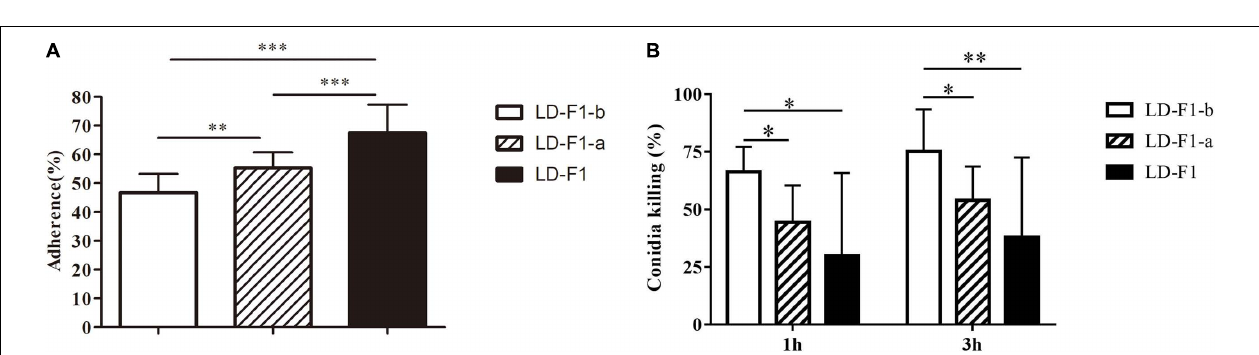
FIGURE 8 | Comparisons of virulence in mice of virus-free isolate (LD-F1), AfPV1-infected isolate (LD-F1-b), and AfPV1- and SatRNA-infected isolate (LD-F1-a) by lateral tail vein injection. (A) Determination of the optimal spore concentration of A. flavus for pathogenicity testing in mice and the immunosuppressed mice were infected with 40 µ L spores of A. flavus isolate LD-F1 ranging in concentration from 10 4 , 10 6 to 10 8 CFU/mL. (B) Survival of mice infected with spores of virus-free isolate (LD-F1), AfPV1-infected isolate (LD-F1-b), and AfPV1- and SatRNA-infected isolate (LD-F1-a) over a 14 days incubation period. (C) Fungal burden in lung, kidney, and liver tissue over 7 days. Control experiments are comprised of untouched mice (UTC) and saline buffer injected immunosuppressive mice (Mock). P -values were estimated using Log rank, non-parametric Kruskal–Wallis and Dunn’s multiple comparison tests. * P < 0.05, ** P < 0.01, *** P < 0.001.